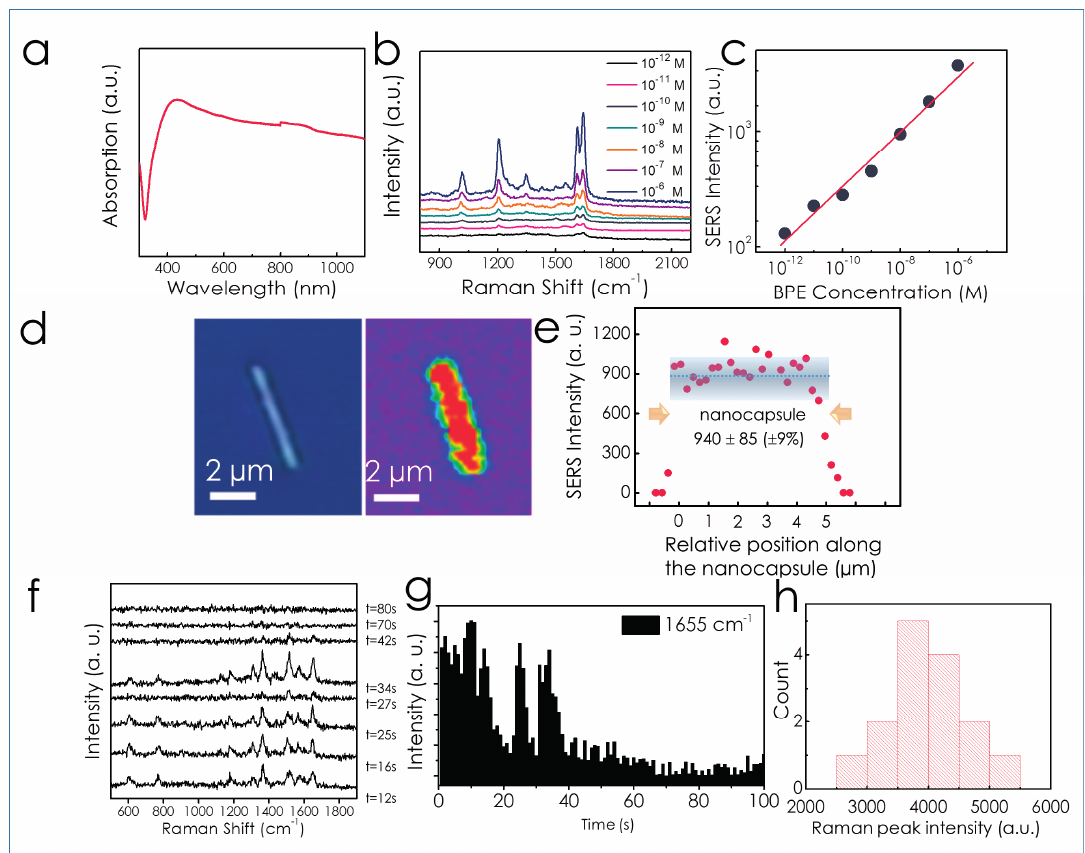
Figure 8. ( a ) Optical absorption spectrum of the nanocapsules without metal cores; ( b ) SERS spectra of BPE from 1 pM to 1 µM; ( c ) The SERS intensity increases with concentrations of BPE at 1644 cm − 1 ; ( d ) SERS mapping profile of 1 µM R6G dispersed on a nanocapsule shows uniform SERS intensity on the surface of the nanocapsules ( e ) SERS intensity distribution along a single nanocapsule; ( f ) On/off SERS spectra of R6G molecules in a 100-sec time frame with 1-sec integration for each spectrum; ( g ) SERS Intensity fluctuation as a function of time (@1655 cm − 1 ) (with permission from [71]); ( h ) SERS intensity of 100 nM nile blue solution @ 595 cm − 1 detected from different nanocapsules fabricated in the same